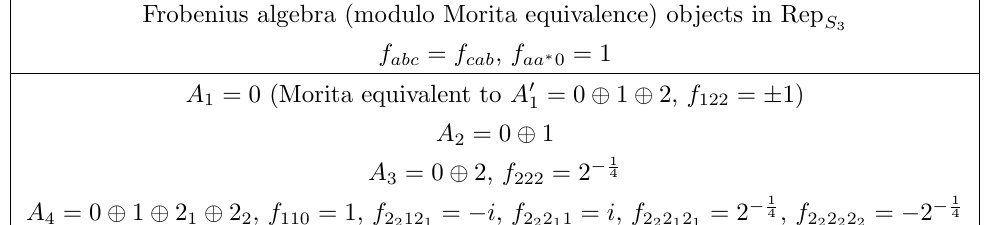
Table 4 . Inequivalent Frobenius algebra objects in the UFC Rep conditions (4.1). Frobenius algebra objects A 1 = 0 and A 0 One thus can forget about A 0